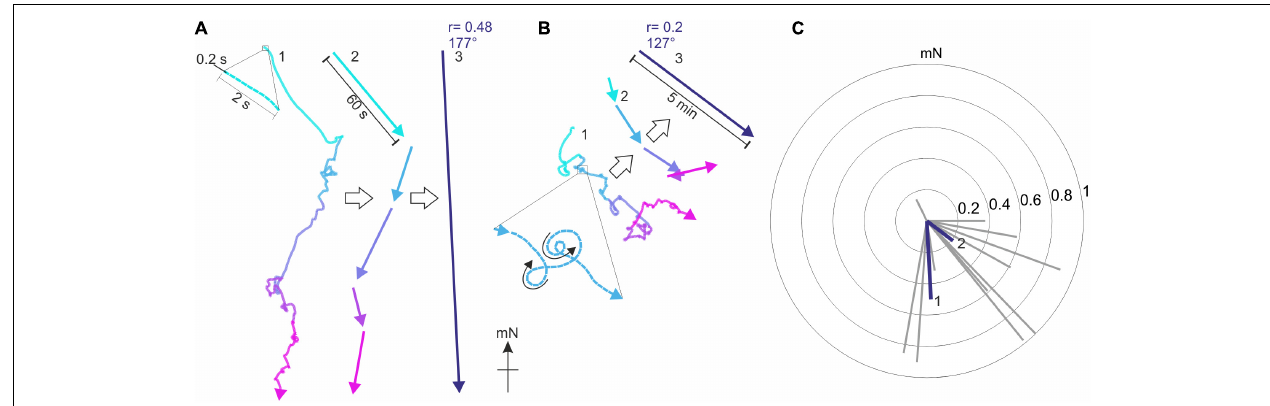
FIGURE 4 | Typical virtual flight tracks recorded by the encoder system. (A) The virtual flight track of a Red underwing moth ( Catocala nupta , RU#11) recorded in Illmitz (Austria) over 5 min of consecutive flight (each minute is represented by a different color ), plotted relative to magnetic North (mN). In 1, the entire 5 min flight track is shown with the moth’s flight direction recorded every 0.2 s (see enlargement ), while in 2 the resultant vectors calculated for each minute of the same track are shown. 3 shows the resultant flight trajectory vector of RU#11 ( r = 0.48, α = 177 ◦ ), based on the 0.2 s samples recorded over 5 min of consecutive flight. (B) As in A, but for the track of another Red underwing moth (RU#5) recorded at the same location. This particular individual was less oriented than RU#11, as seen in the comparably shorter lengths (i.e., lower r values) of the resultant vectors in 2 and 3. Note that even though moth RU#5 flew in many loops (see enlargement in 1), it was able to fly both clockwise and counter-clockwise ( black arrows in 1), a good indicator that the stalk was attached symmetrically to the thorax of the moth and that neither of the wings were damaged. (C) The vectors of 14 Red underwings are plotted as gray radial lines in a circular diagram [the vectors of RU#11 (1) and RU#5 (2) are plotted in blue ]. The radii of the concentric circles indicate the r value (from 0 to 1) at increasing step-size from the center toward the periphery. Based on these 14 vectors, we can also investigate the orientation behavior of the moths as a single population by employing the Moore’s modified Rayleigh test